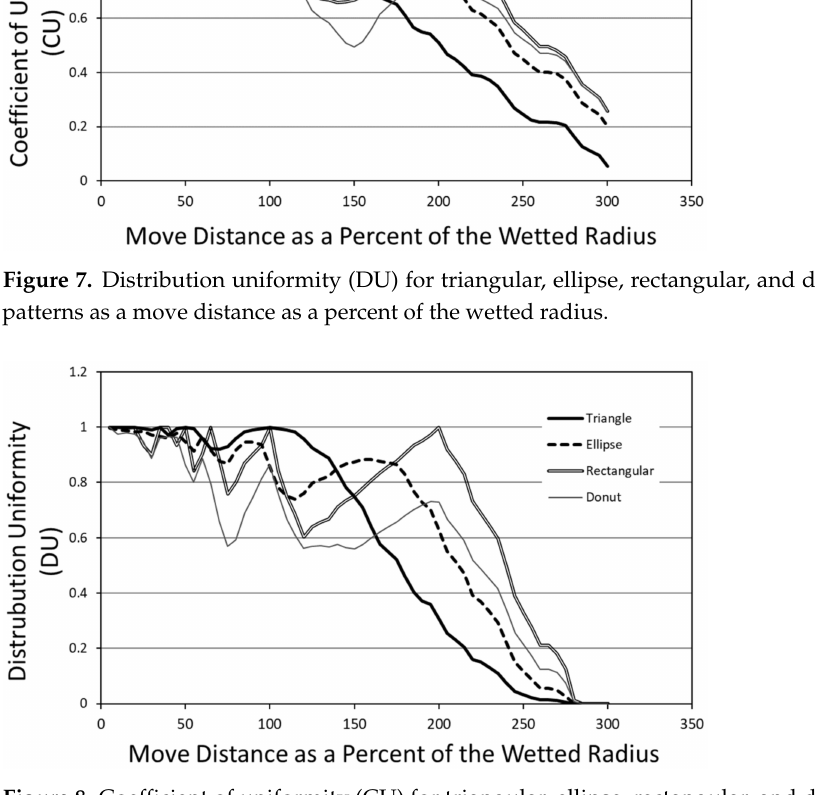
Figure 8. Coefficient of uniformity (CU) for triangular, ellipse, rectangular, and donut application patterns as a move distance as a percent of the wetted